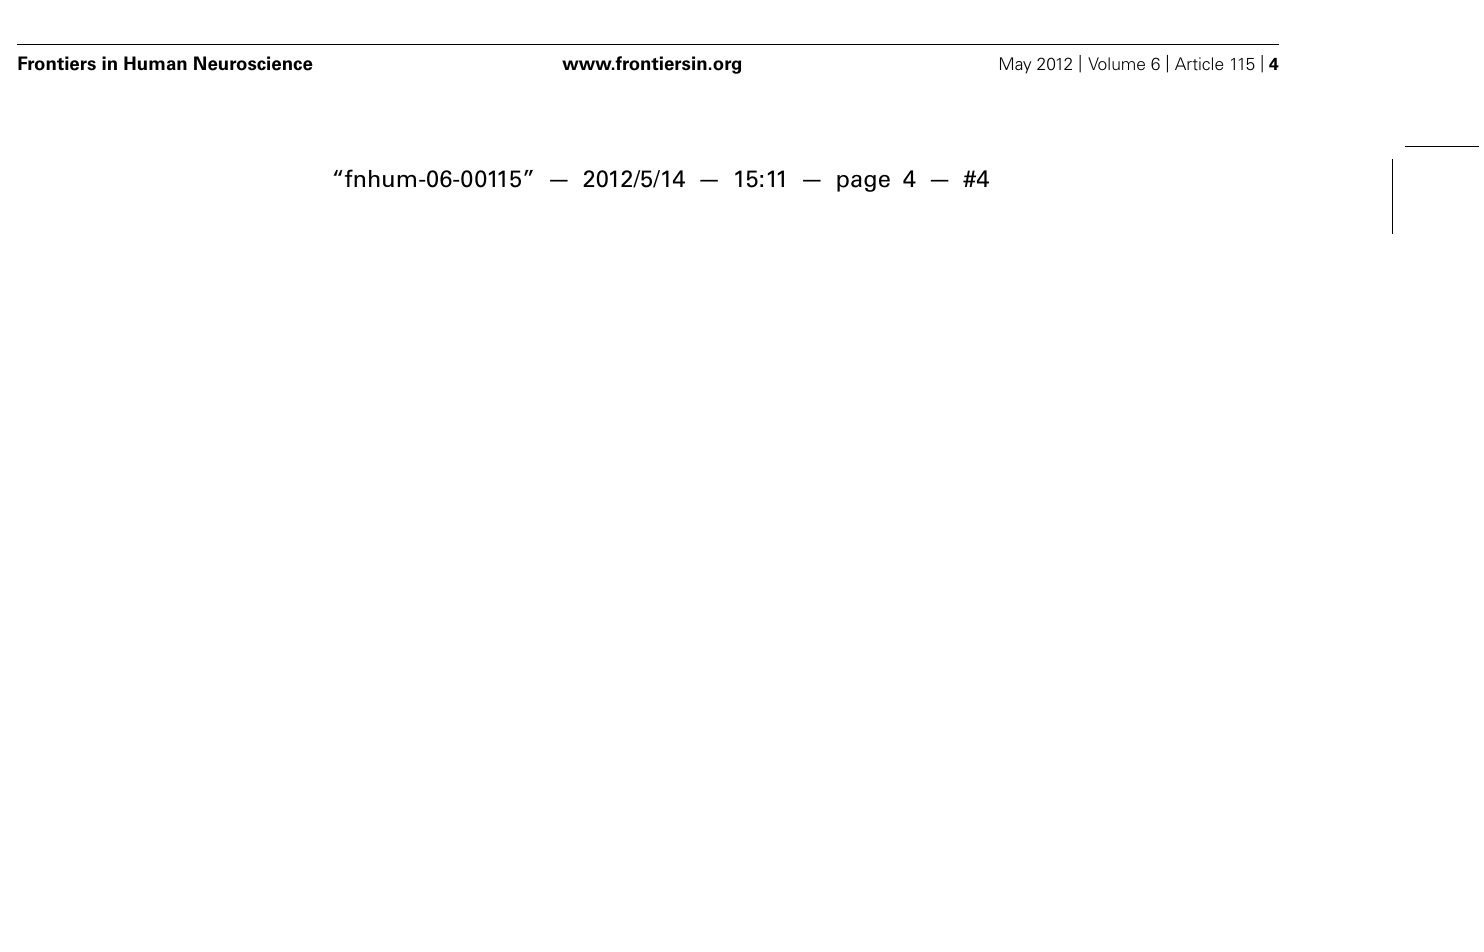
Players are awarded a total score for each game, which is the sum of four sub-scores (Control, Velocity, Speed, Points). The main task in the SF game is for the player, represented by a ship, to destroy a SF, which is located in the center of the screen within two hexagons, using missiles allotted to them. The ship flies in this environment with no brakes, so the player must exercise slight, precise movements of the joystick, keeping the ship in the large hexagon, and a failure to do so results in a reduction of Control scores. Successfully destroying the SF contributes to the Point sub- score. Players are penalized if they improperly execute the series of missile launches required to destroy the fortress and if the fortress’ missiles hit the